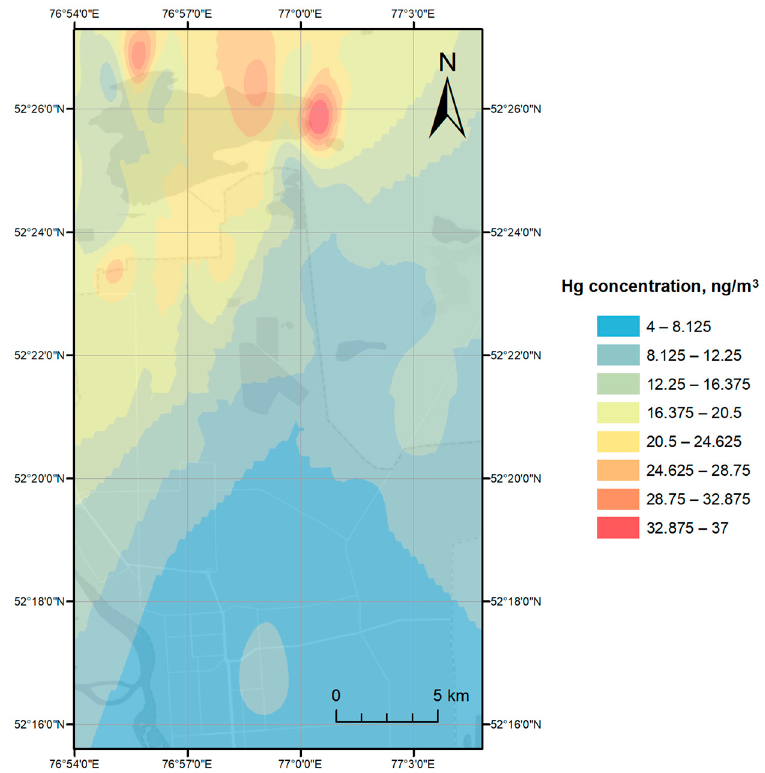
Figure 3. Atmospheric Hg dispersion over region around Lake Balkyldak during Campaign 1.